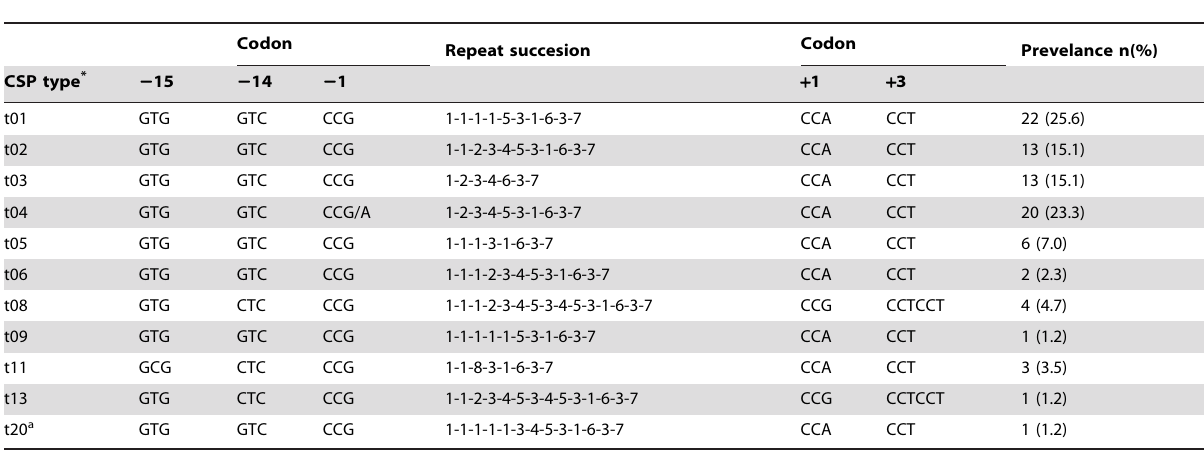
Table 2. Overview of the identified CSP types among clinical A. fumigatus